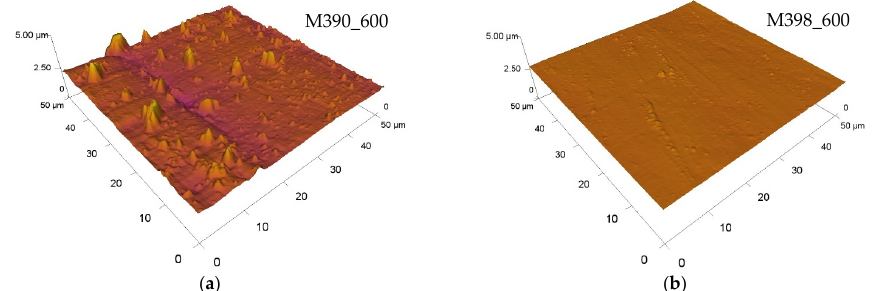
Figure 14. Three-dimensional comparison of material roughness values of M390 and M398: ( a ) M390_600 and ( b ) M398_600.